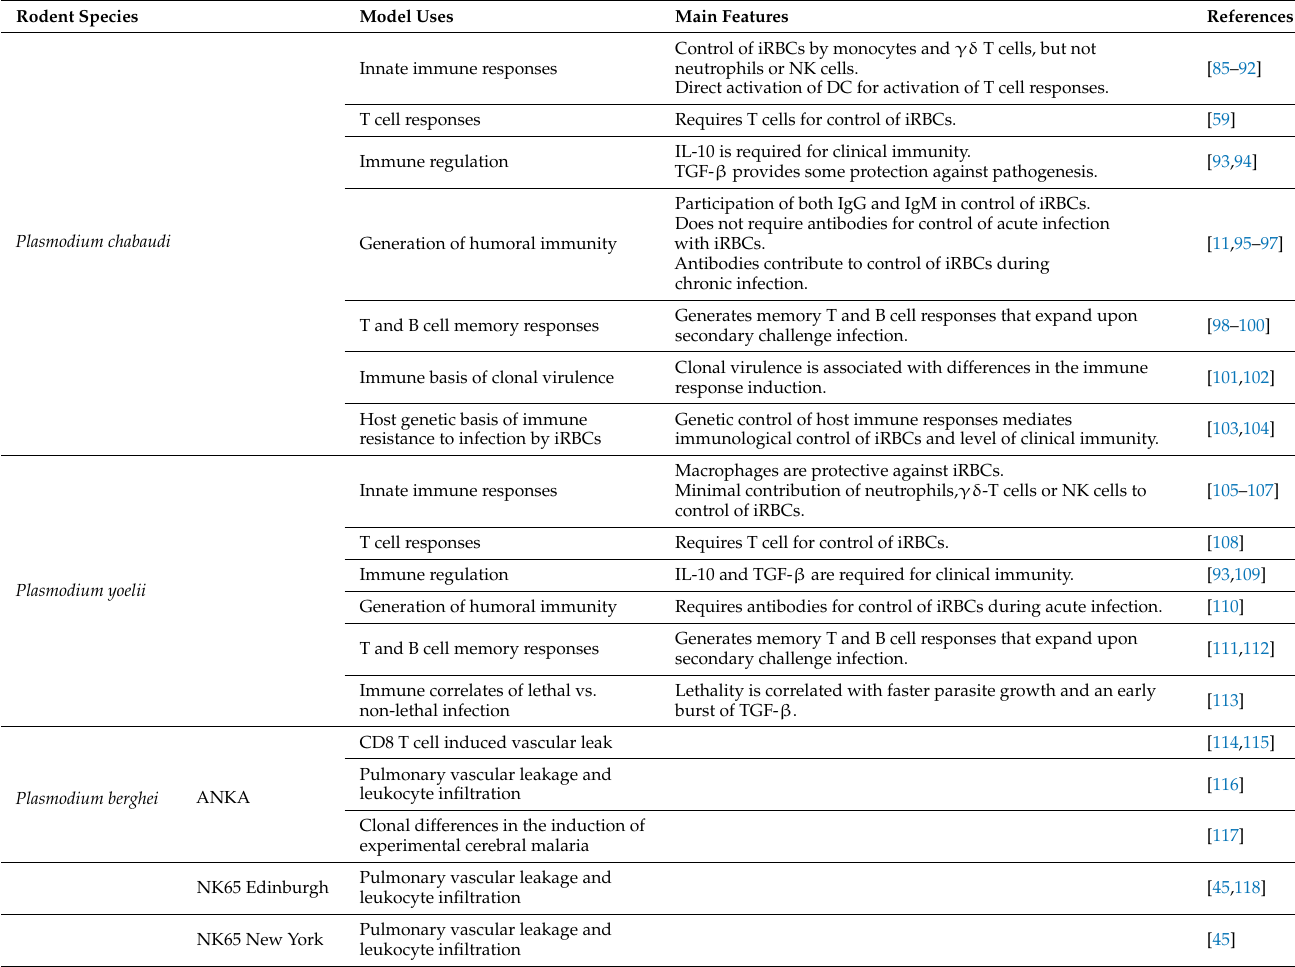
Table 3. The main immunological features of the three most widely used Plasmodium species in the study of the immune response elicited by Plasmodium -infected